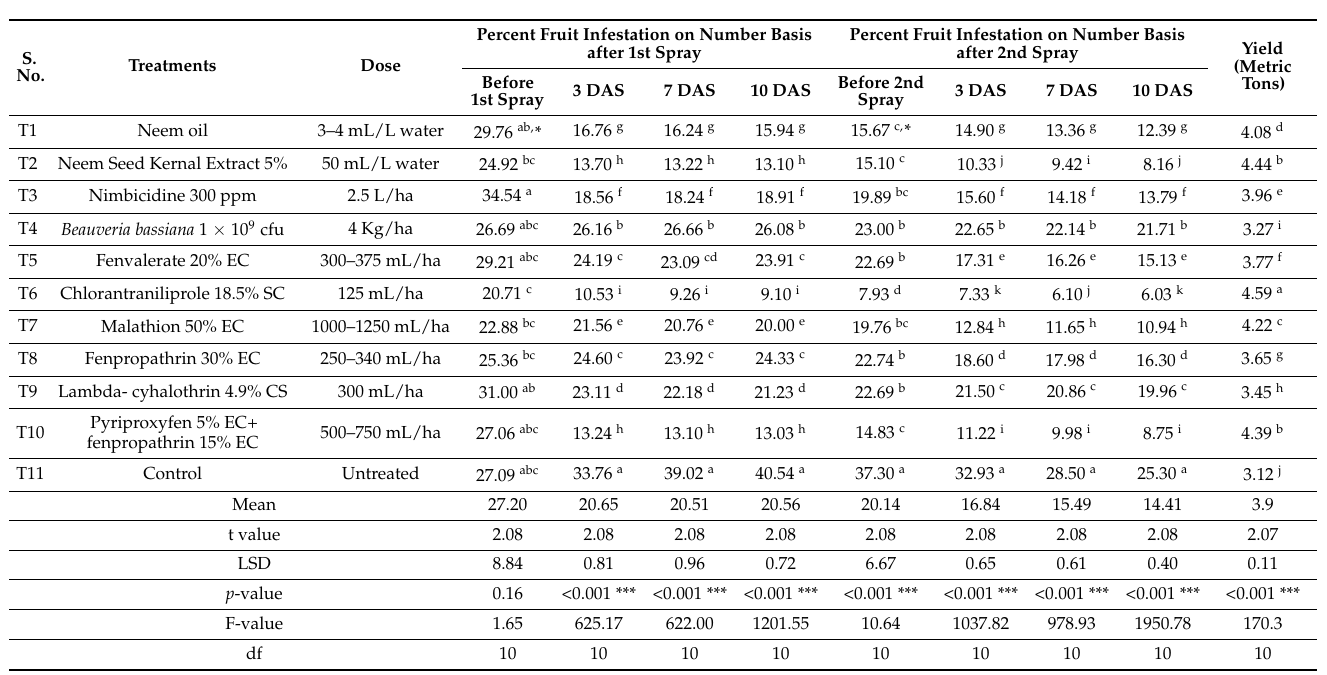
Table 2. Efficacy of 10 recommended insecticides against okra fruit and shoot borer ( Earias spp.) compared to a no insecticidal control in regard to the percentage of fruit infestation on a number basis following the application of two insecticidal spray